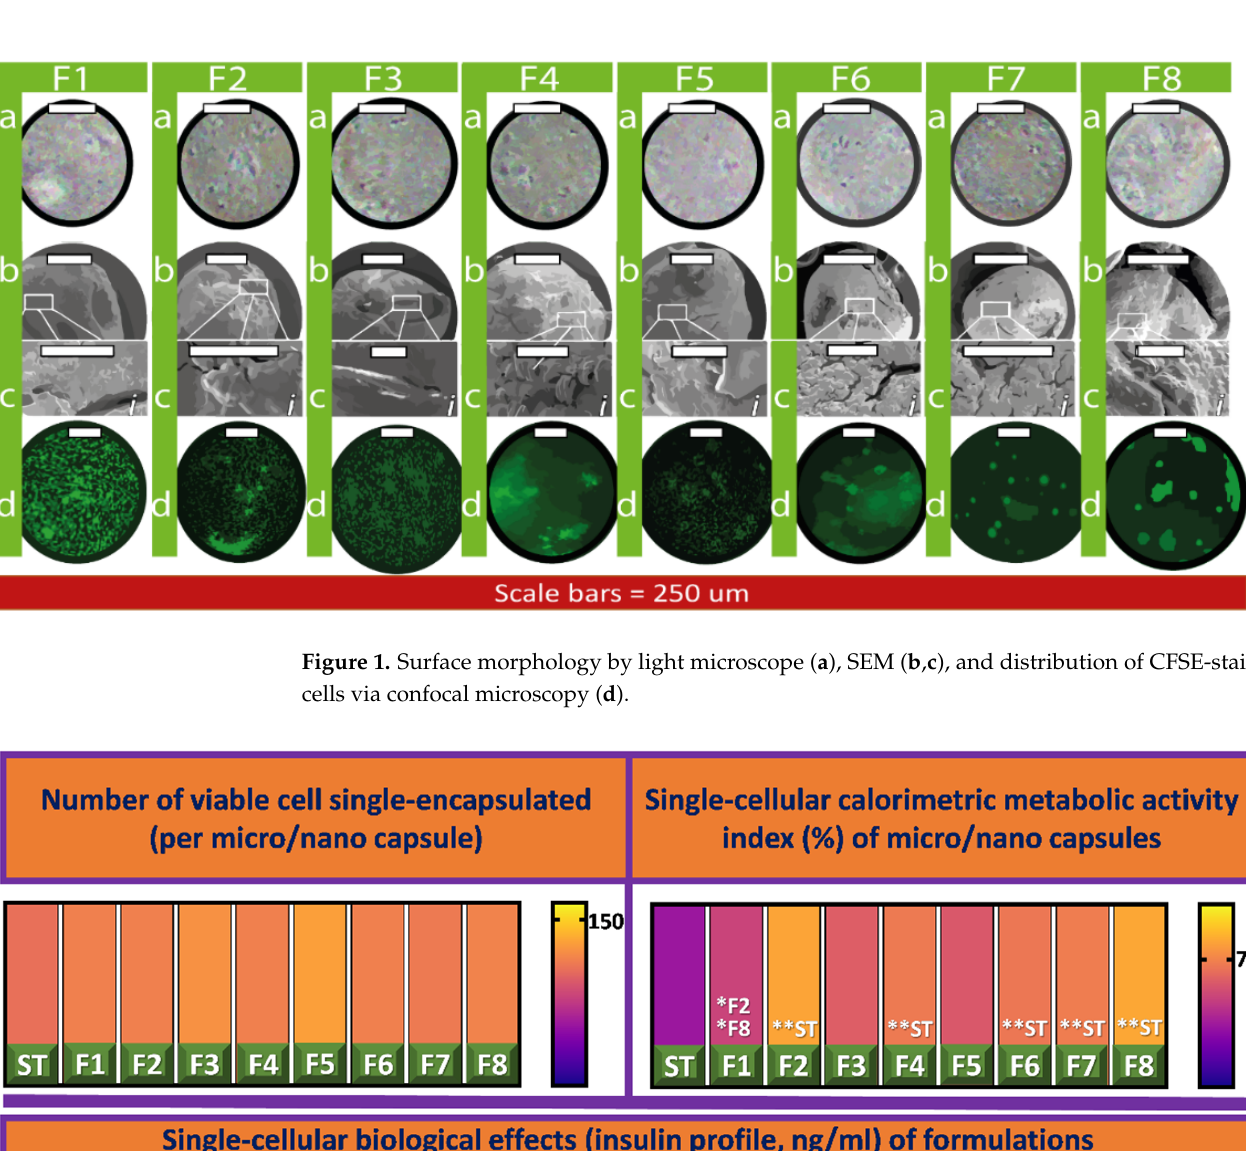
Figure 2. Cell viability ( top , left ), metabolic activity ( top , right ), schematic representation of exper- imental theory ( middle ), and insulin profile ( bottom ). Data are mean ± standard error of the mean, n = 3. Singular asterisk denotes where p < 0.05, whereas double asterisk denotes p < 0.01.